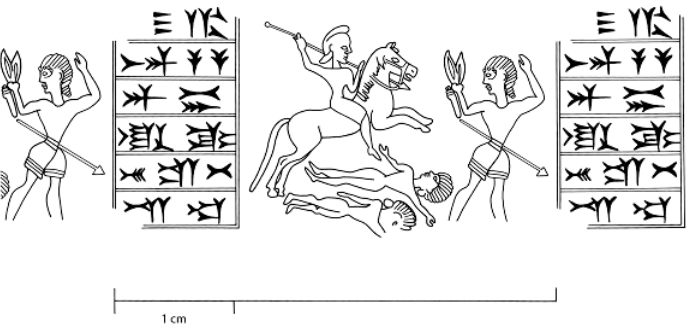
Figure 1. Collated line drawing of the heirloom seal of Kurash the Anzanite (PFS *93) [image courtesy of the Persepolis Fortification Archive Project and the Persepolis Seal Project].